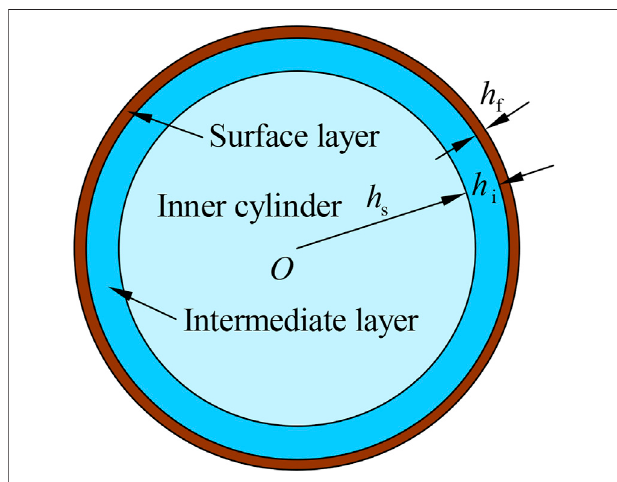
FIGURE 3 | A cross-section of a soft cylinder covered by a